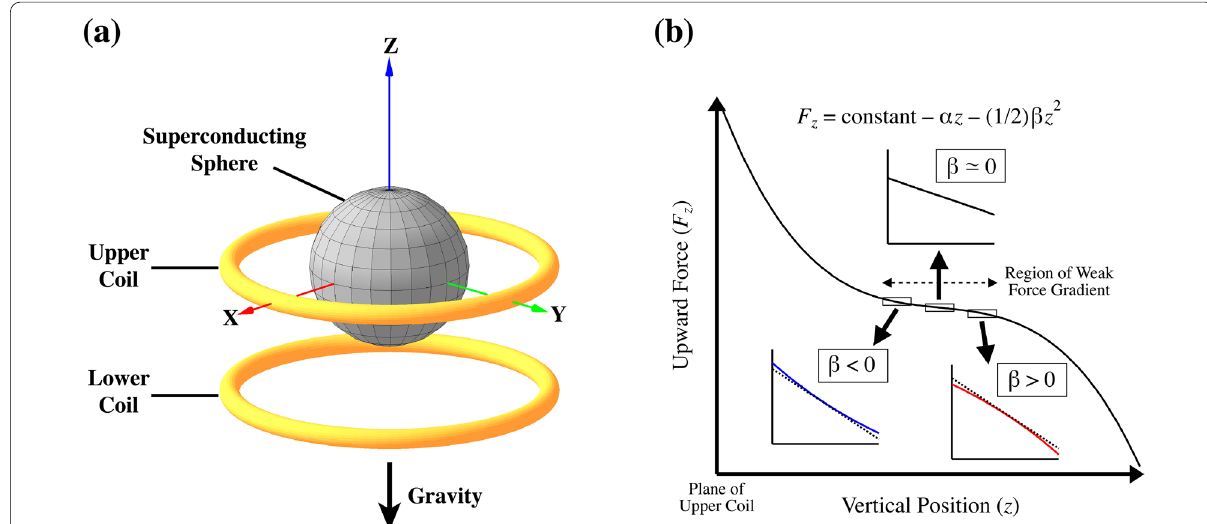
Fig. 2 The gravity sensor of the superconducting gravimeter. a Superconducting sphere and coils. b Vertical force applied to the levitating sphere as a function of vertical position. The vertical force gradient is made weak for a limited interval of the vertical coordinate ( z ). Ideally, the force should be linearly dependent on z . In reality, there exists a small but finite quadratic term, which gives rise to nonlinear responses of the gravimeter